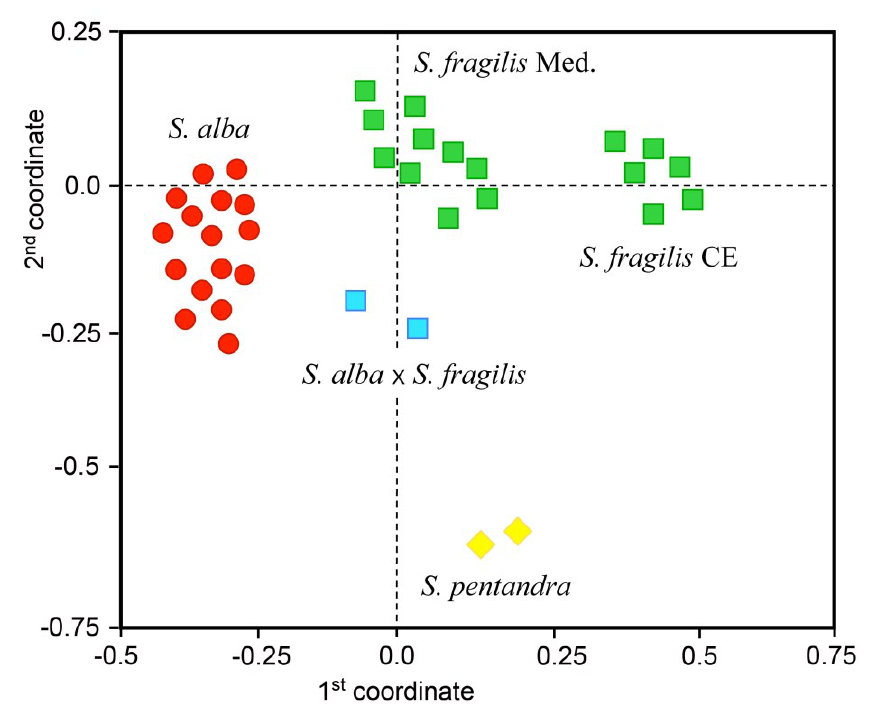
Figure 1. Outcome from UPGMA (unweighted pair-group method with arithmetic mean) grouping analysis of Salix spp. samples on the basis of molecular amplified fragment length polymorphism (AFLP) fingerprints, depicting genetic relationships among S. alba and S. fragilis pure species, S. alba × S. fragilis hybrids, using S. pentandra as outgroup entities. Centroids of the 36 willow trees were obtained from the mean genetic similarity matrix and bi-dimensionally plotted according to the first two components that explain about 60% of the total genetic variation detected across all marker